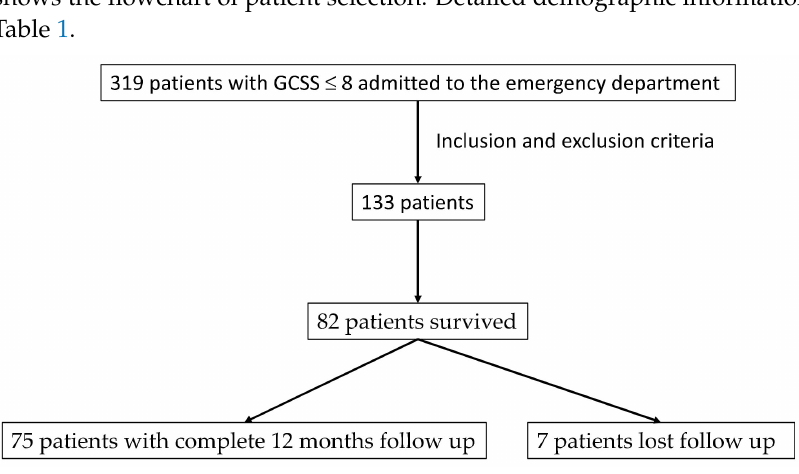
Figure 1. Flowchart on sample